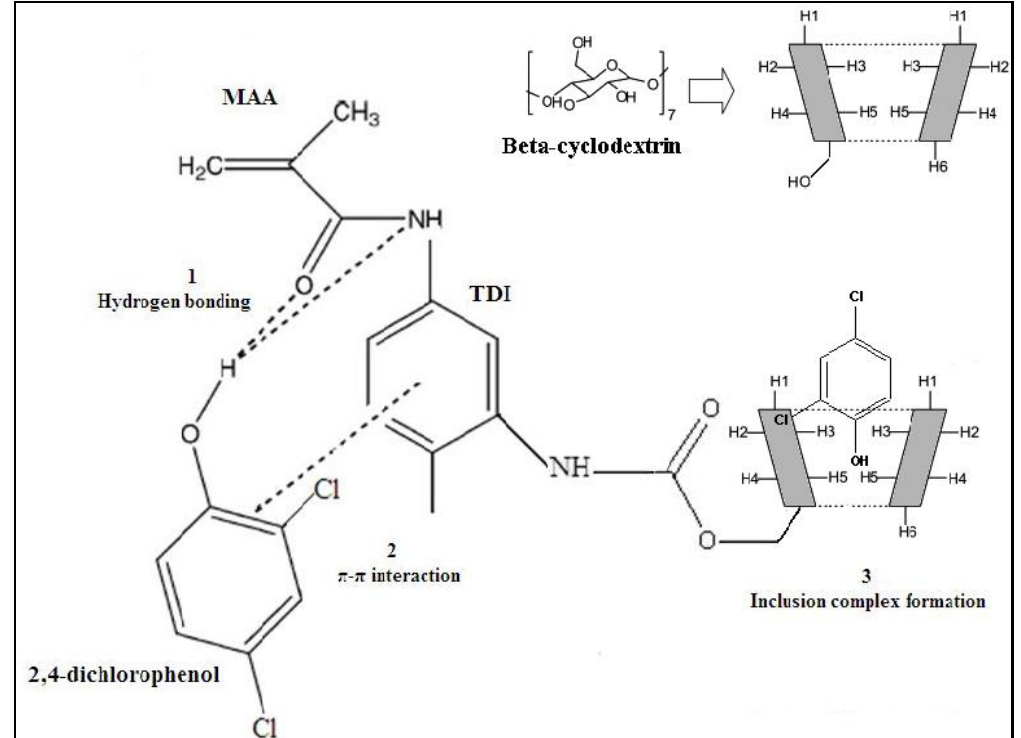
Figure 7. The proposed interaction mechanism between functional monomer, MAA-βCD and 2,4-DCP